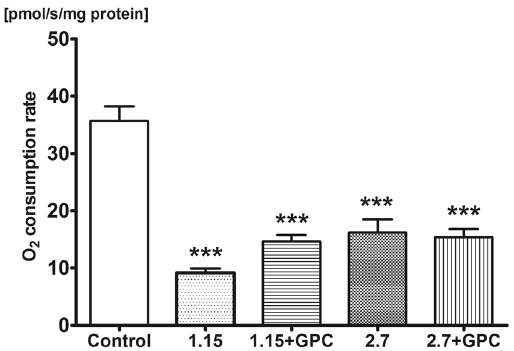
Figure 5. Oxygen consumption of rat hippocampus mitochondria. O 2 consumption rate of mitochondria was assessed in hippocampus homogenate after addition of 0.5 μ M rotenone, 10 mM succinate and 2.5 mM ADP on day 9 of investigation. Mitochondrial respiratory capacity deteriorated upon alcohol intake regardless of GPC treatment. Mean values and standard error of mean (SEM) are given; *** p < 0.001 vs . Control. Statistics: One- way ANOVA with Bonferroni post-hoc